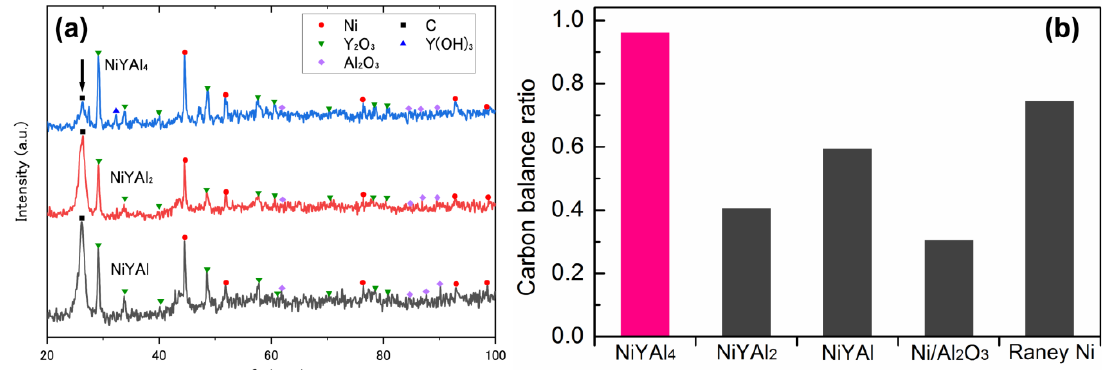
Figure 5. ( a ) X-ray diffractograms of the spent catalysts prepared from NiYAl 4 , NiYAl 2 , and NiYAl intermetallic precursors. The arrow indicates the position of the carbon peak. ( b ) Carbon balance ratio for the present catalysts and reference catalysts. Carbon balance = {CO formation rate/(CH 4 consumption rate + CO 2 consumption rate)}.